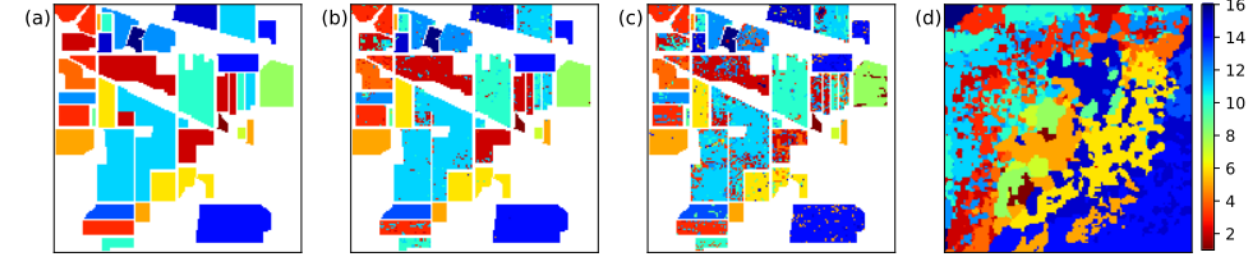
Figure 17. ( a ) The Indian Pines scene ground truth labels. ( b ) the scene classified by the SVM. ( c ) The scene classified by the 128 128 5 SOM. ( d ) the class labels on the nodes of the × ×